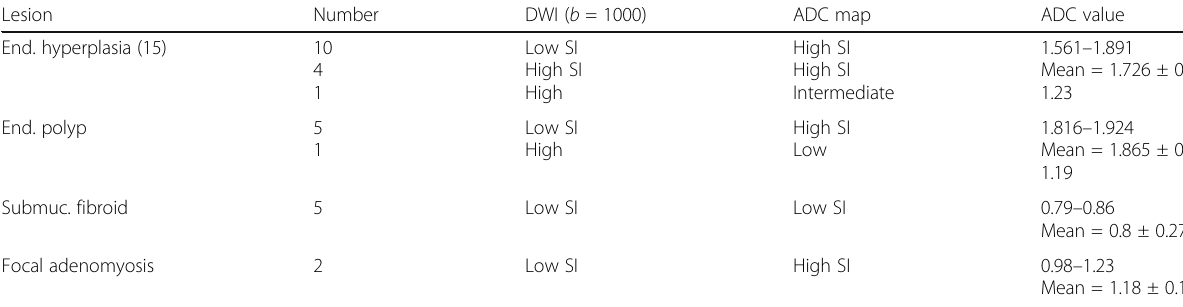
Table 3 DWI and ADC map findings in group I (benign lesions, n = 28) Lesion